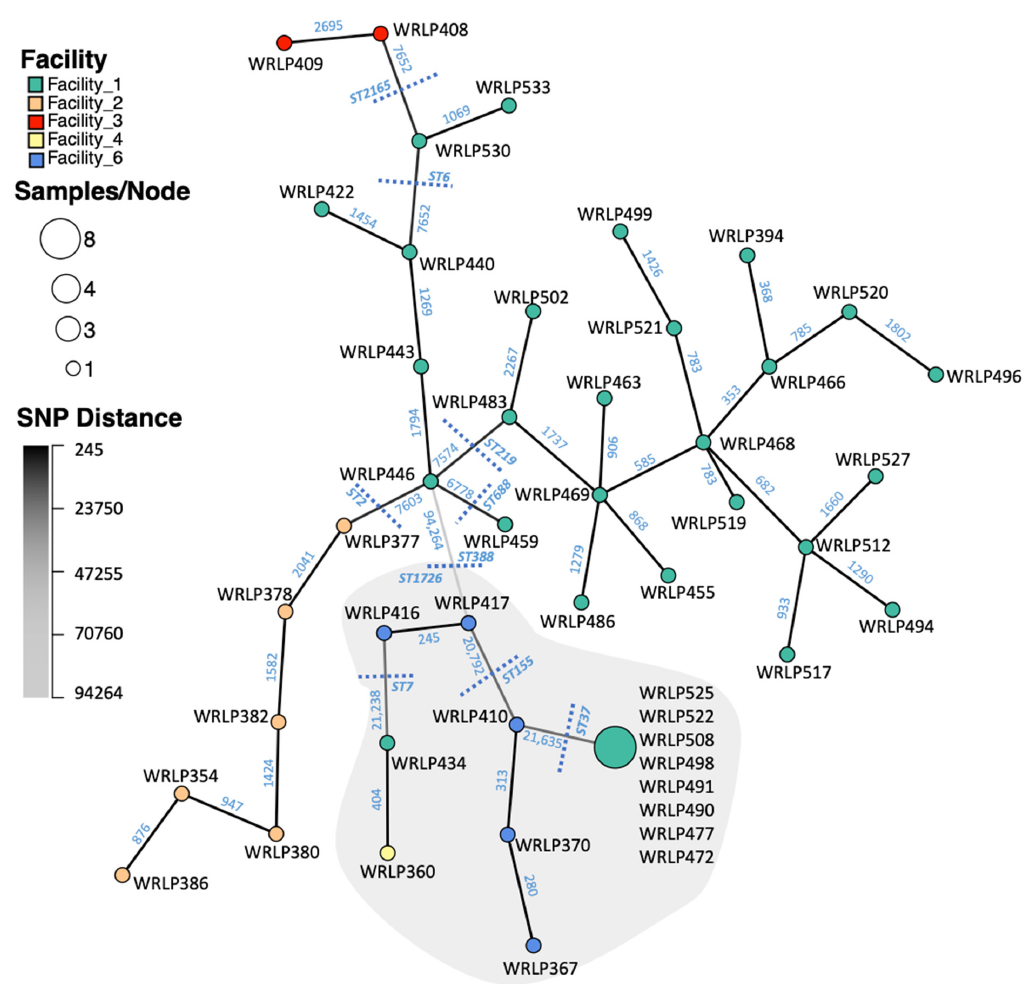
Figure 2. Minimum spanning network (MSN) of whole genome SNPs identified amongst 48 Listeria monocytogenes genomes. Nodes represent genotypes of isolates with <3 pairwise SNP differences and node size is proportional to the number of isolates of that genotype. Node color indicates the produce facility where each strain was sourced. Branch color and bales indicate the number of pairwise SNPs between genotypes (i.e., darker colors indicate fewer differences). Dashed lines illustrate where ST groupings fall in relation to the minimum spanning network. Grey background shows isolates belonging to lineage II (serotype 1/2a or 3a) whereas a white background shows isolates belonging to lineage I (serotype 4b, 4d, or 4e).